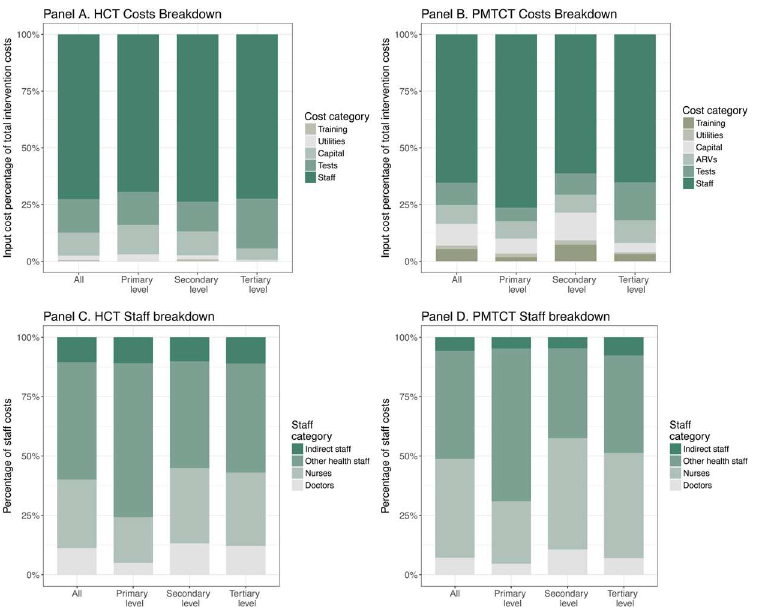
Fig 2. Breakdown of HCT and PMTCT costs, by level of